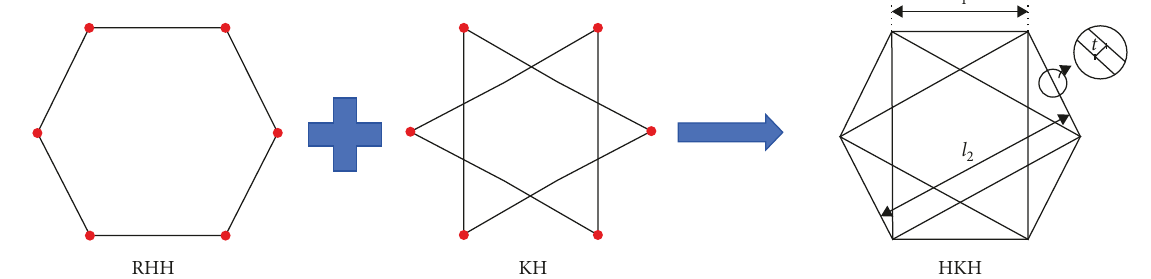
Figure 1: Design concept for novel combined honeycomb (HKH) and the geometric configuration of the honeycomb.